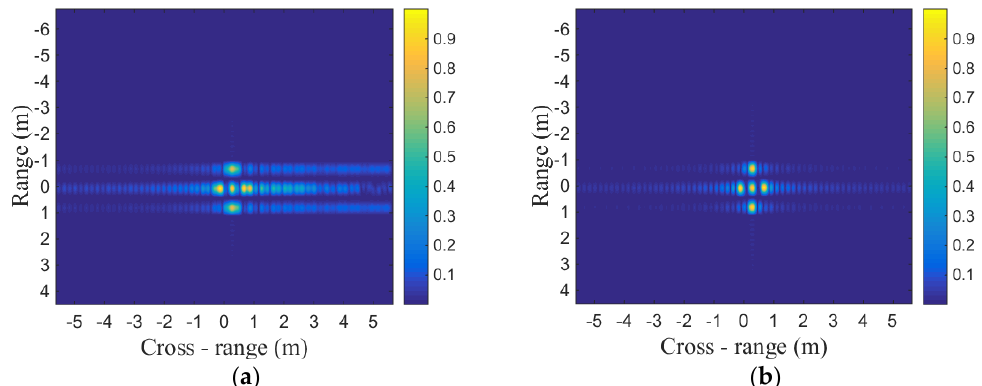
Figure 6. Two-dimensional imaging results: ( a ) imaging results of fused signal with LTFE; ( b ) imaging results of fused signal after calibrating frequency error.